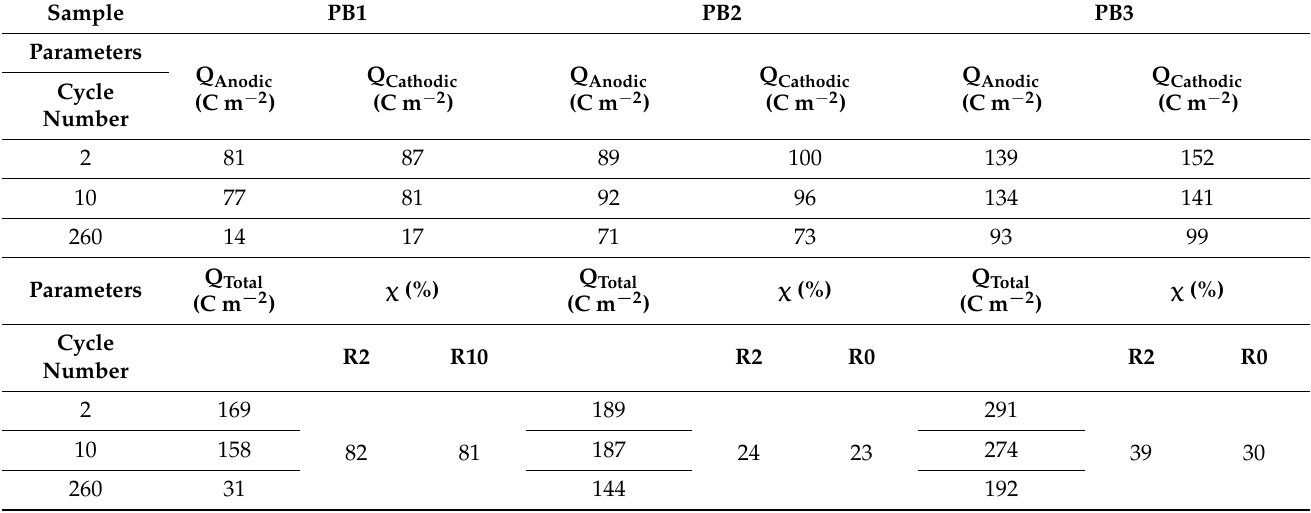
Table 3. The values of anodic, cathodic, and total exchange charges regarding the 2nd, 10th, and 260th CVs for all the PB films, prepared by DC (PB1), symmetric (PB2) and non-symmetric (PB3) pulse methods. R2 and R10 refer to the 2nd and 10th CV reference cycles,